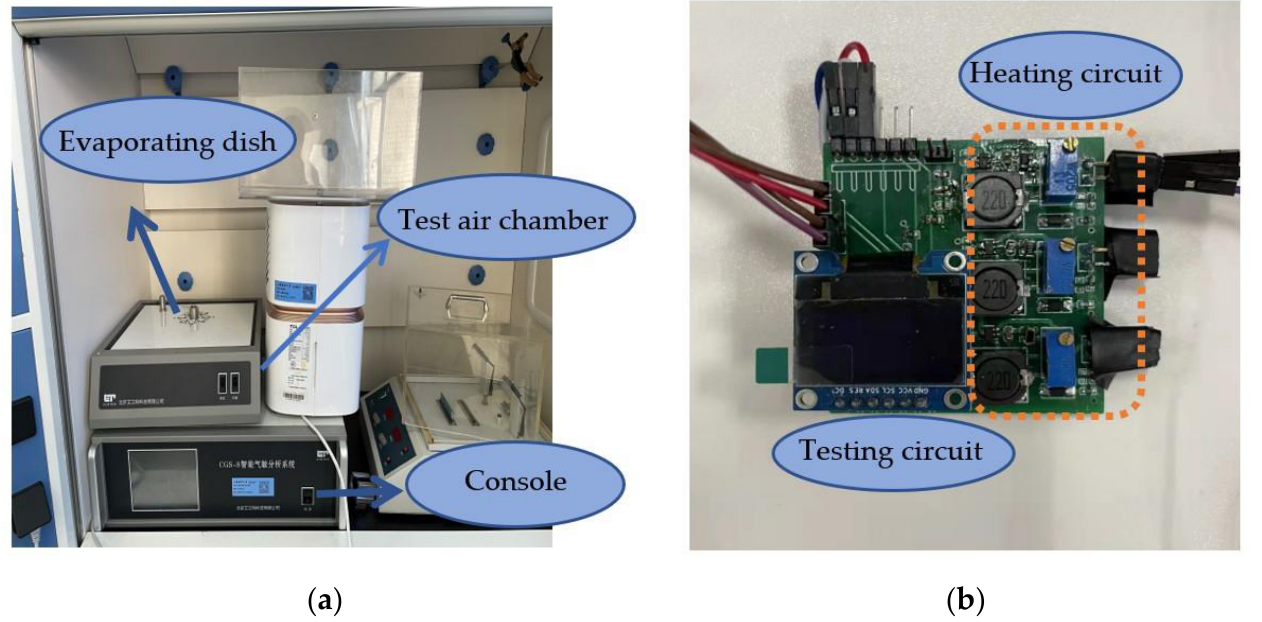
Figure 1. The laboratory equipment and background. ( a ) Gas testing laboratory. ( b ) Homemade electronic nose.